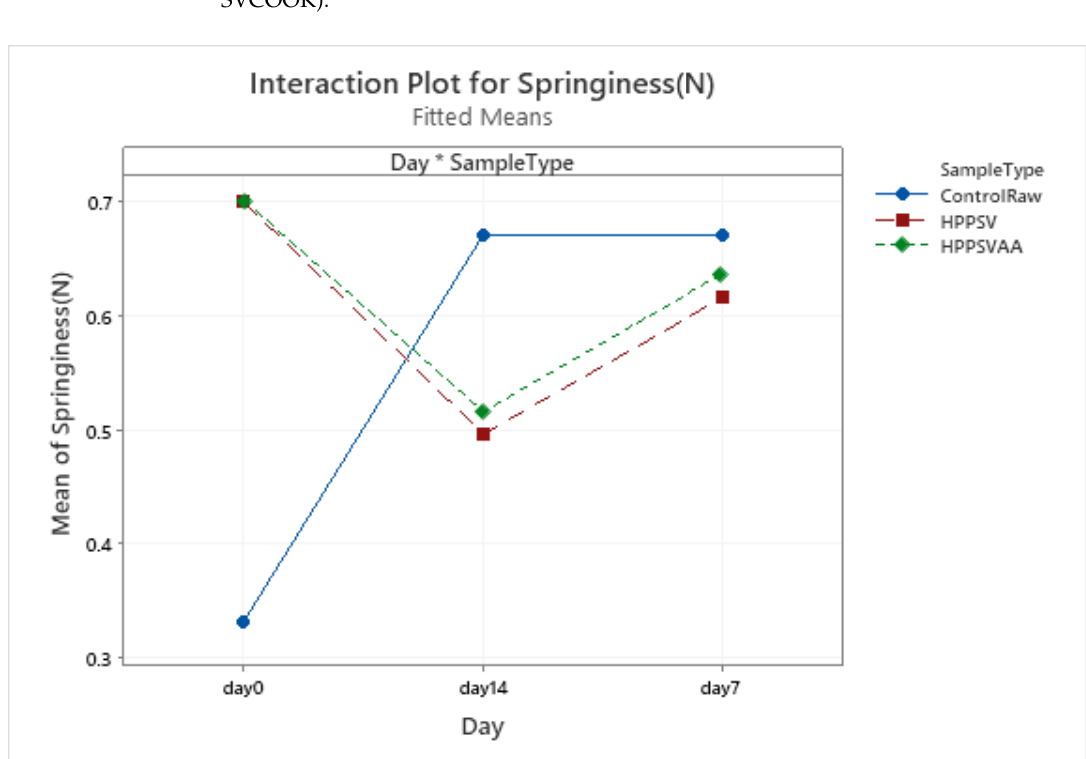
Figure A10. Effect of treatments and storage time on the springiness of hybrid patty (HPPSV: HPP- SVCOOK).